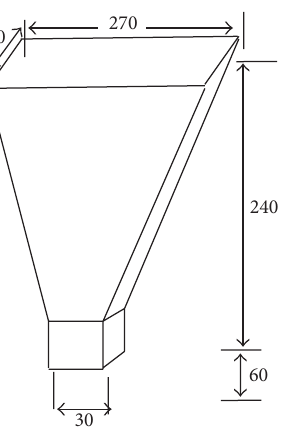
Figure 3: Mortar V-Funnel for powder content